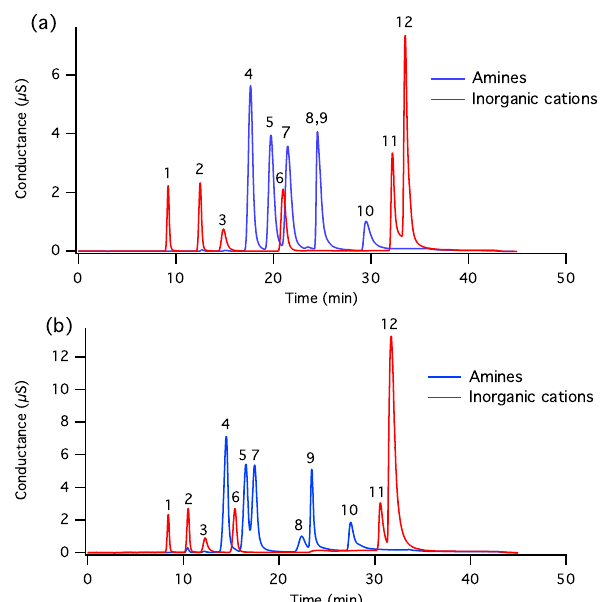
Figure 1. Separation of amine and inorganic cation standards with the highest-resolution gradient program at (a) 30 and (b) 55 ◦ C. The order of elution and mass of cation injected in (a) is as follows: Li + (1, 16ng), Na + (2, 158ng), NH + (3, 169ng), MMAH + (4, 4 500ng), MEAH + (5, 500ng), K + (6, 524ng), DMAH + (7, 500ng), TMAH + (8, 500ng), DEAH + (9, 500ng), TEAH + (10, 500ng), Mg 2 + (11, 128ng), and Ca 2 + (12, 361ng). Cation peaks represent the same mass injected and are labelled according to the same nu- meric identities in (b) .